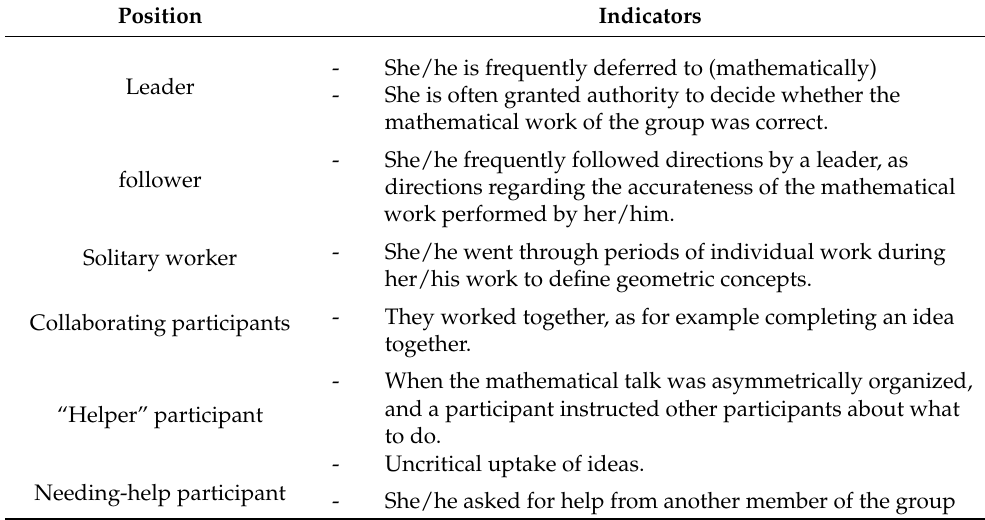
Table 1. Description of